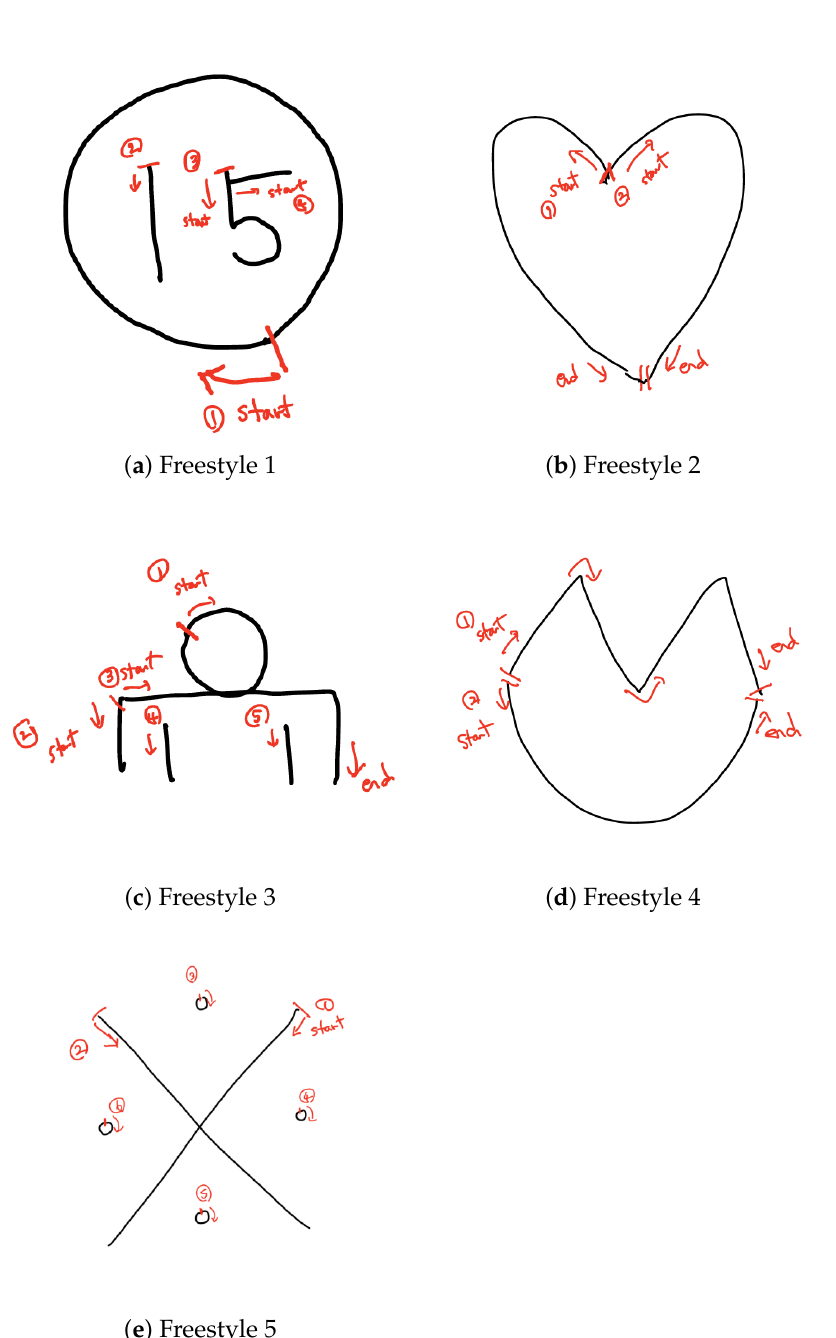
Figure A2. Drawing patterns of the ‘Freestyle’ drawing pattern used in this